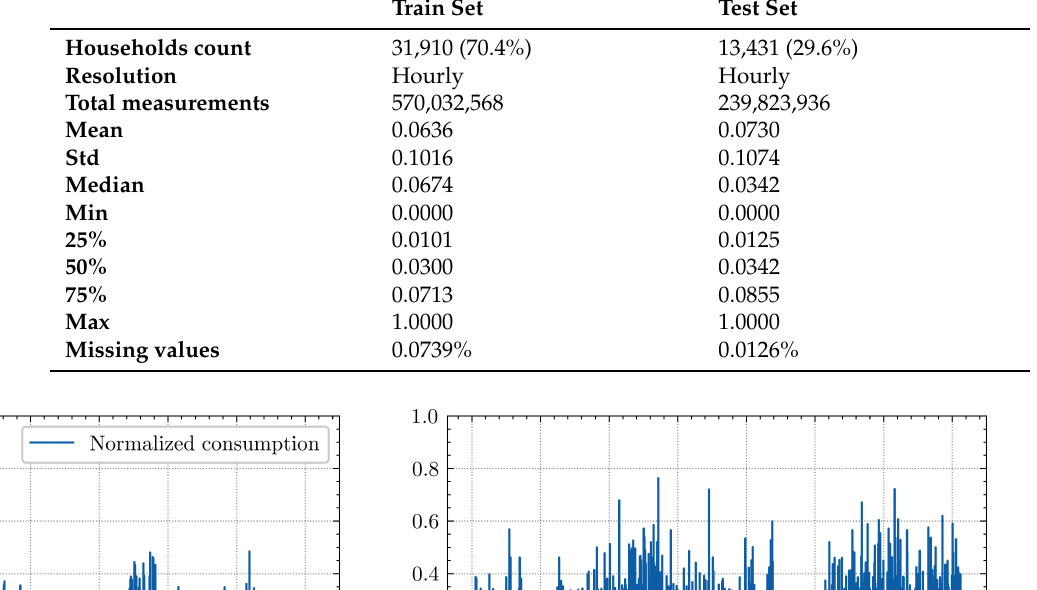
Table 1. Training and test sets description.